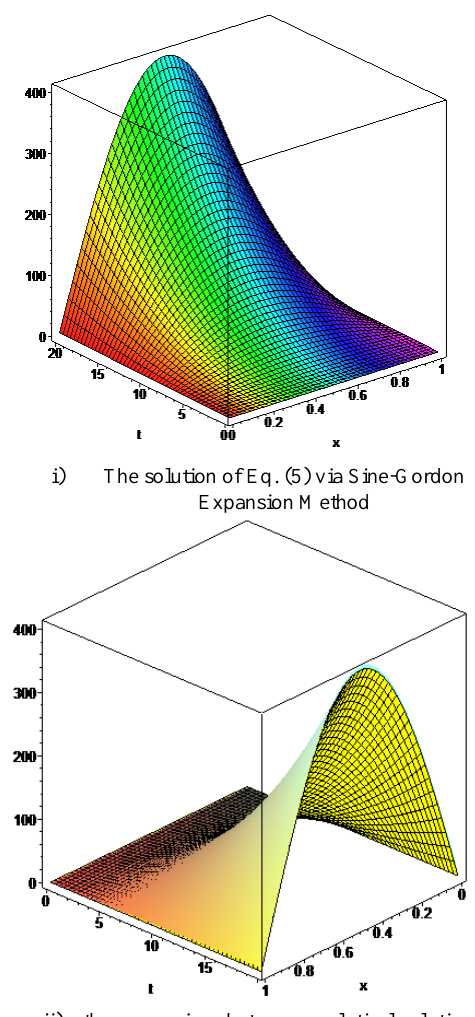
Figure 1. The solutions obtained via Sine-Gordon Expansion